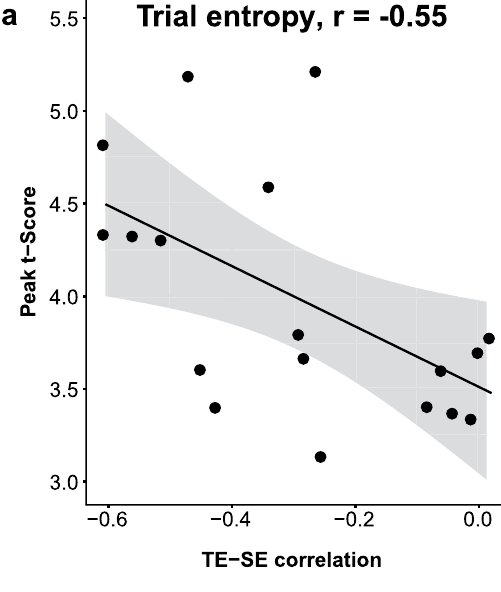
Inter individual variability.